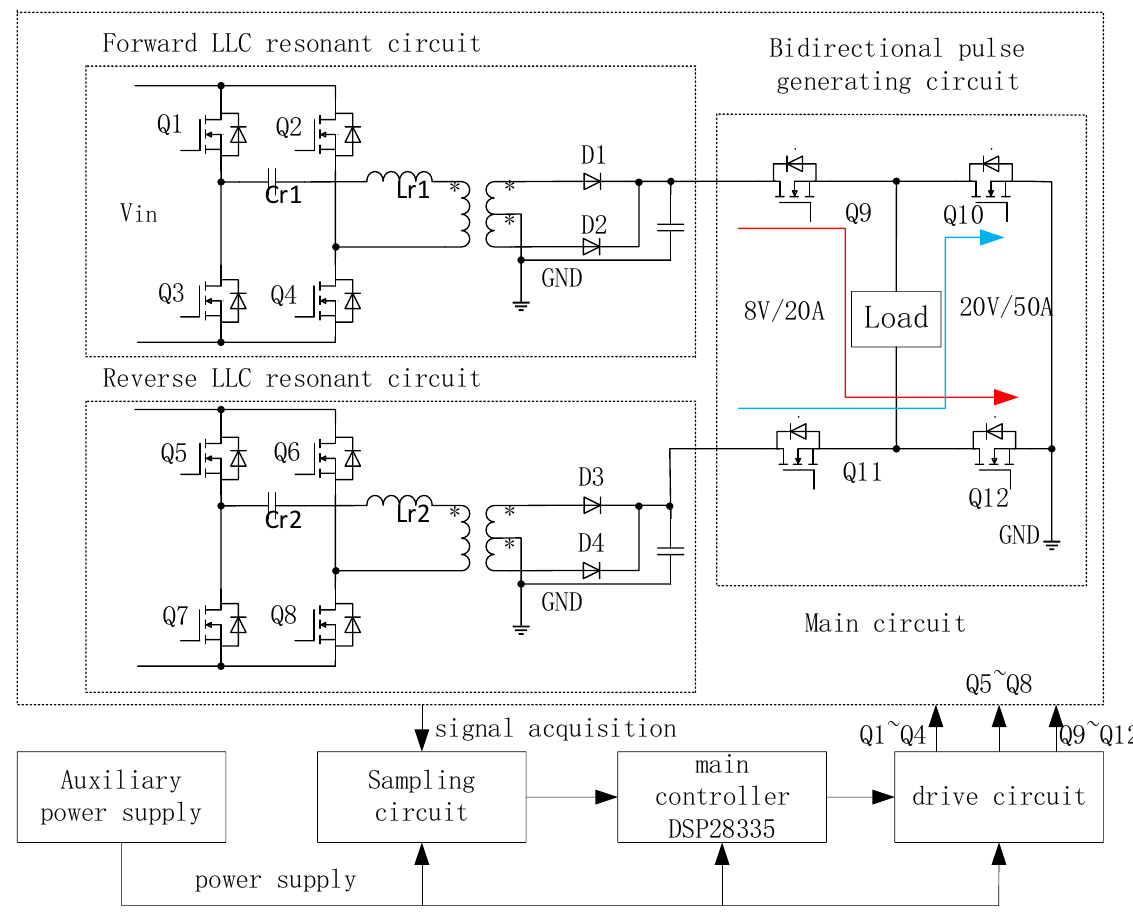
Figure 2. Bidirectional pulse power system structure diagram.